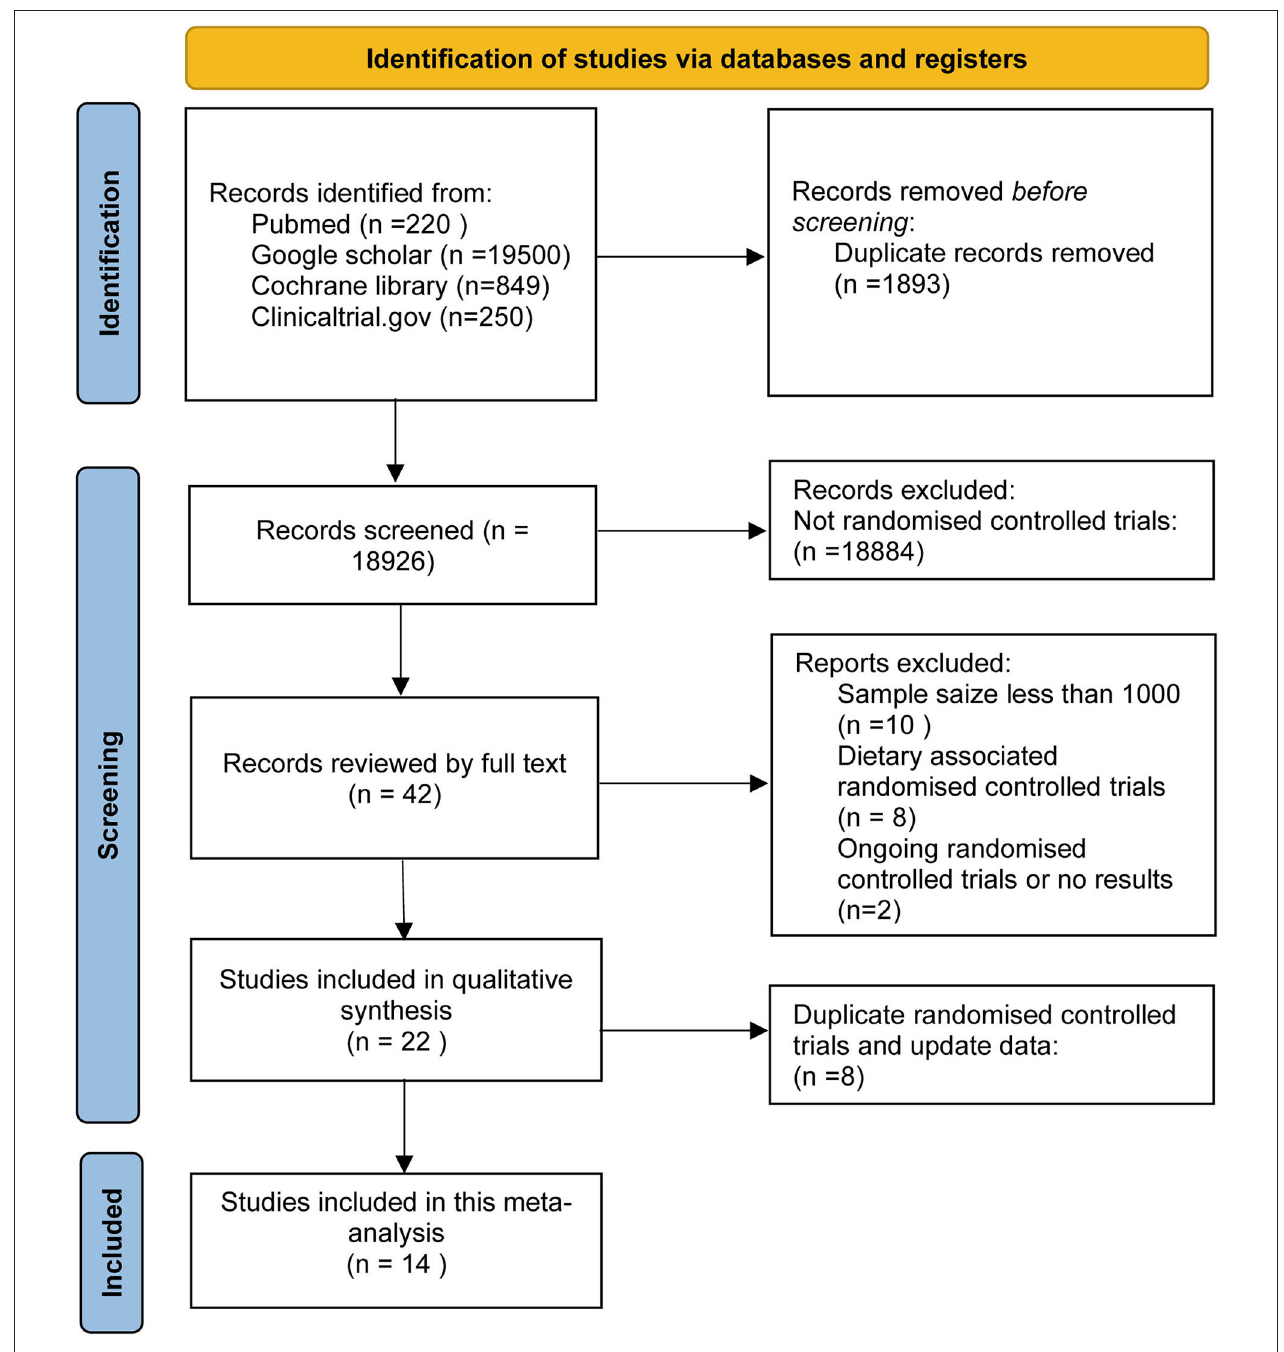
FIGURE 1 | Flow diagram of the study selection process.